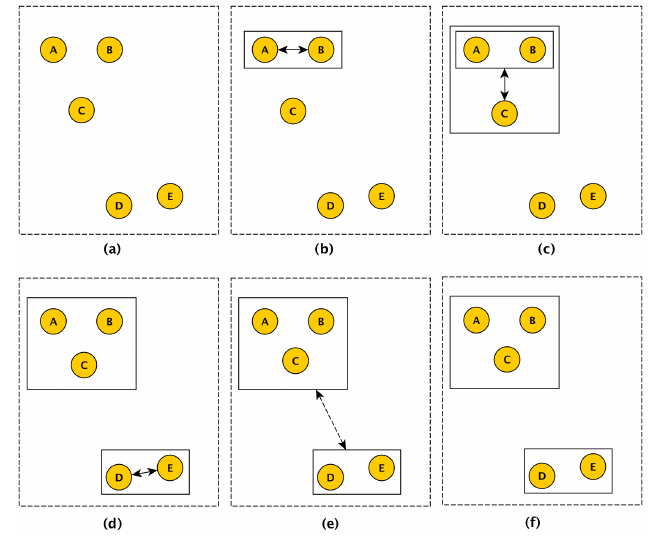
Figure 6. Basic operation of the